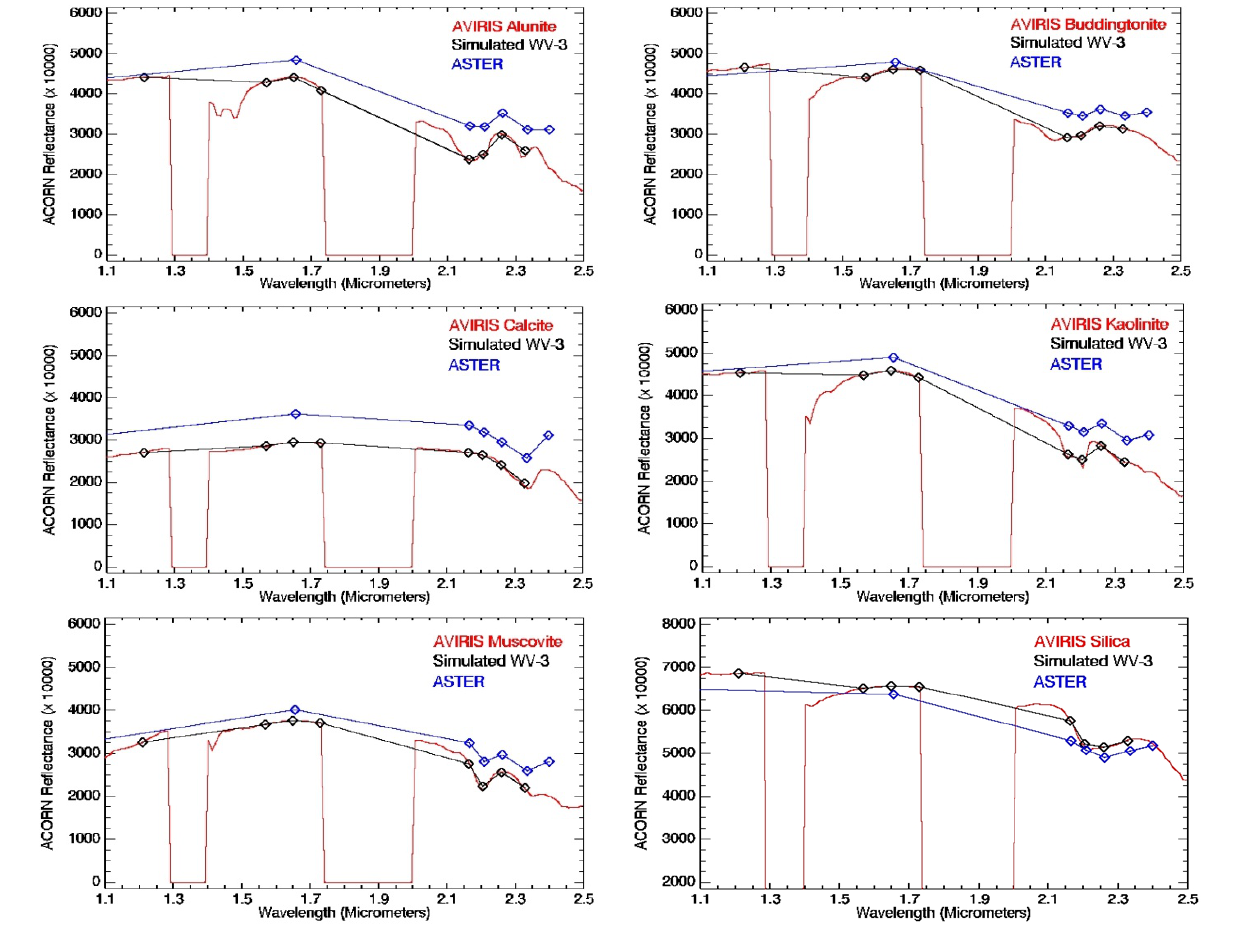
Figure 3. Comparison of AVIRIS (red), simulated WV-3 (black), and ASTER (blue) characteristic spectral signatures (mean endmember spectra) for selected minerals at the Cuprite